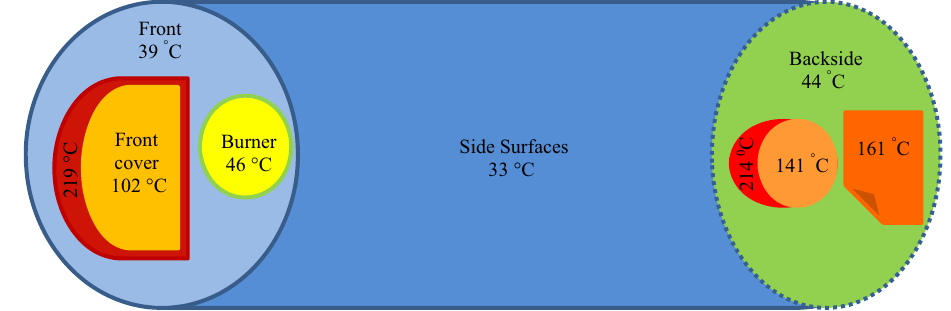
Figure 1: Schematic representation of heat losses in steam